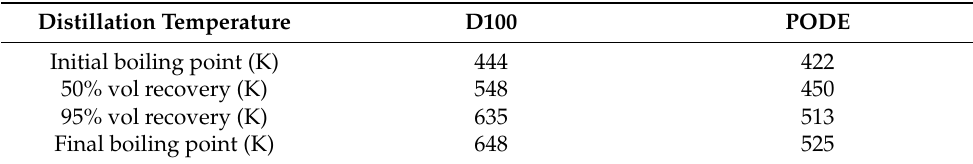
Table 3. Volatility of the diesel and PODE.